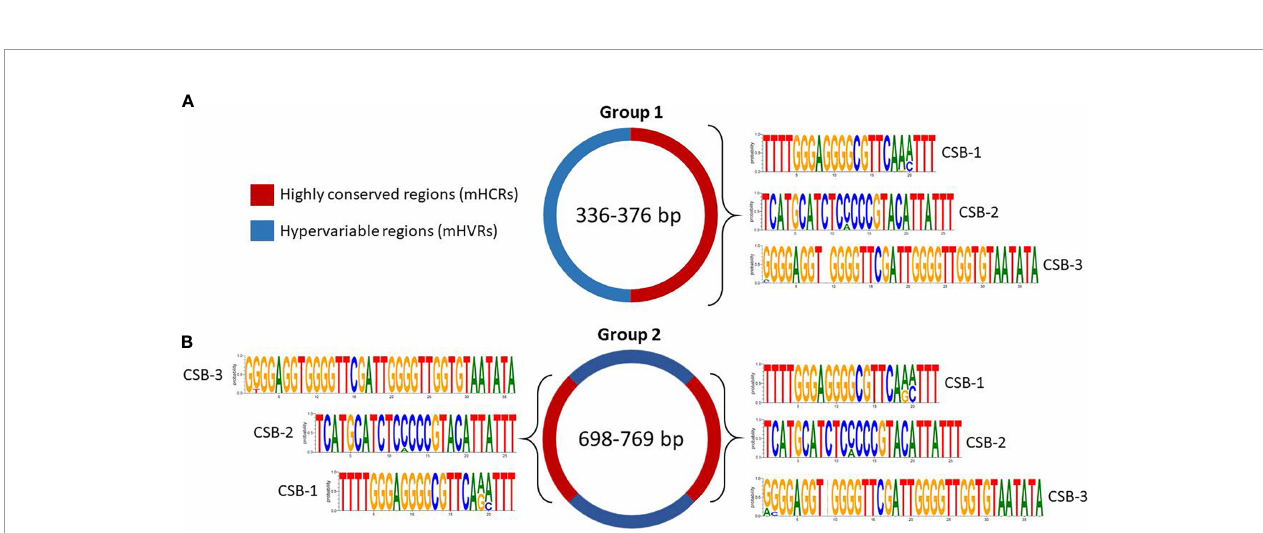
FIGURE 4 | Sequence structure of mHCRs (red) and mHVRs (blue) in group 1 (A) and group 2 (B) of the Y strain minicircles. Logos of the CSB regions are displayed in each